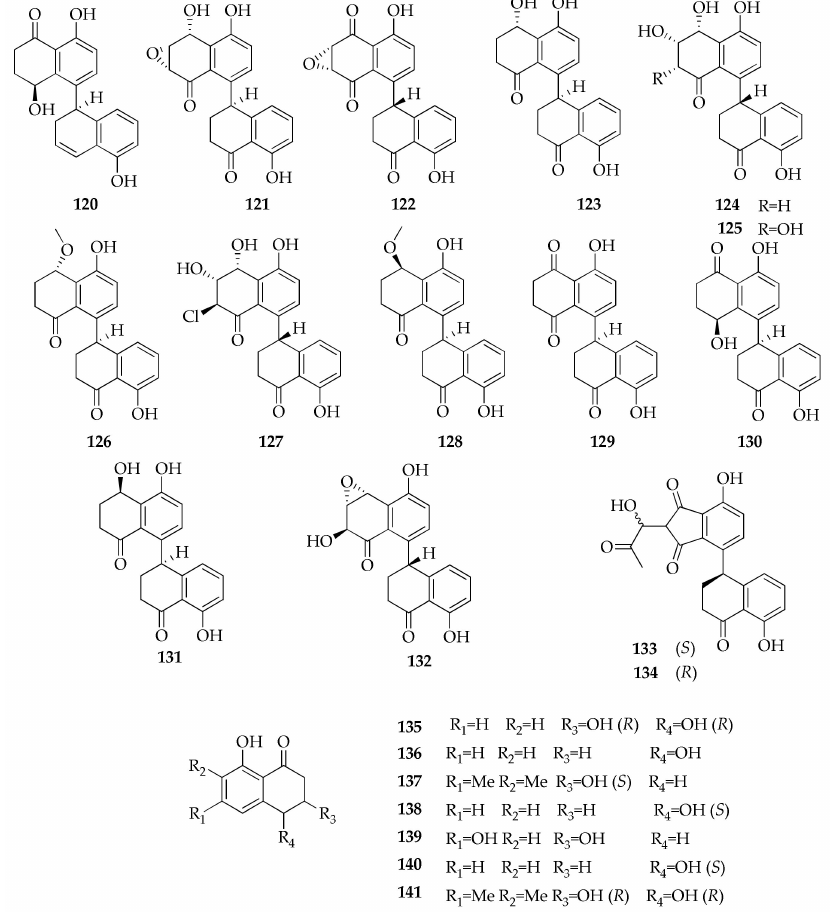
Figure 21. Structures of